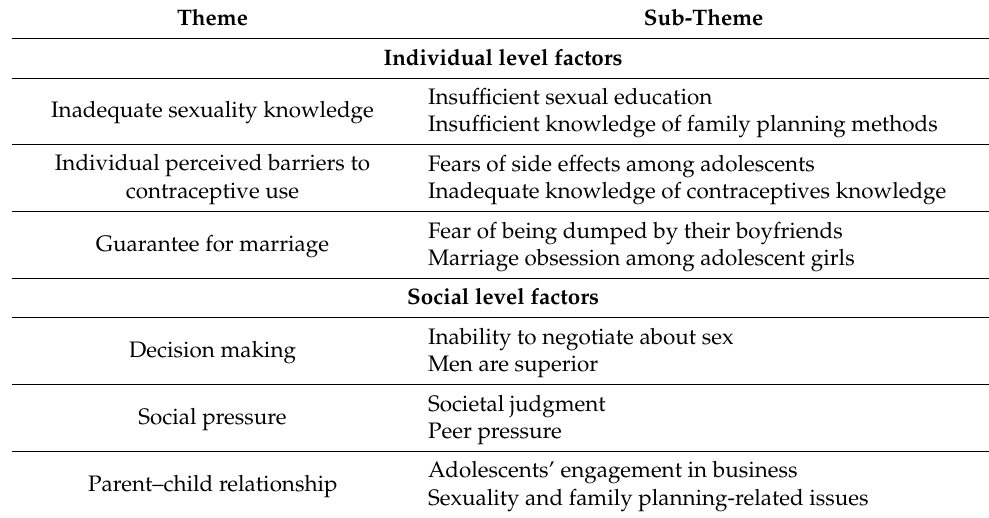
Table 3. Emergent themes and